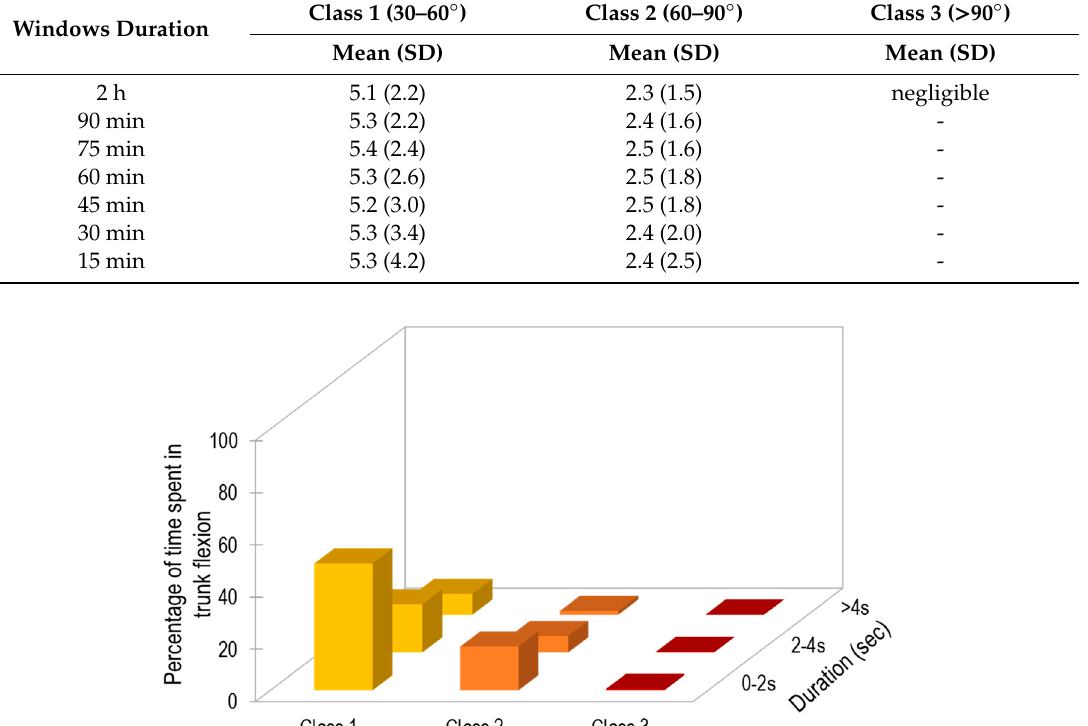
Table 1. Results regarding different classes of trunk flexion. For each class of flexion, means (SD) of the percentage of time spent in different classes of trunk flexion are given from the entire 2 ‐ h observation periods and from several shorter window durations.